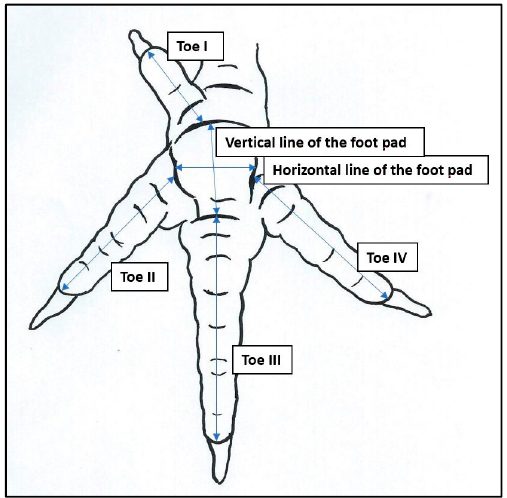
Figure 1. Measurements of the length of toe I, toe II, toe III, and toe IV, and the width and length of the foot pad (blue arrows) (illustration: A. Brandes).